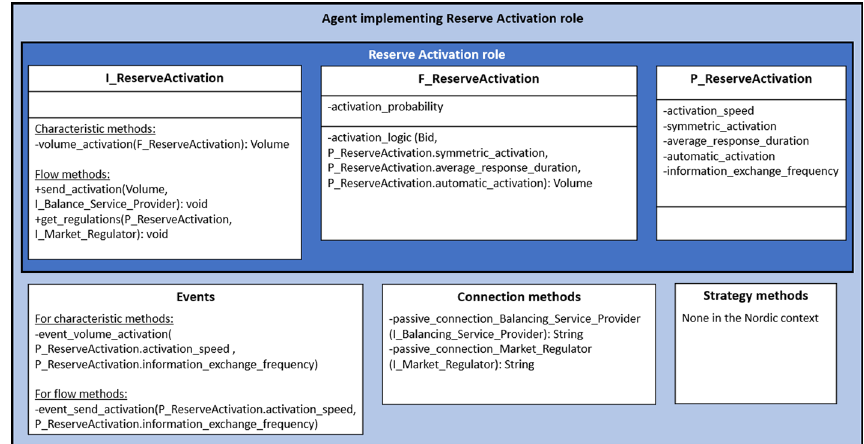
Fig. 11 Interfaces, classes and methods for Reserve Activation role